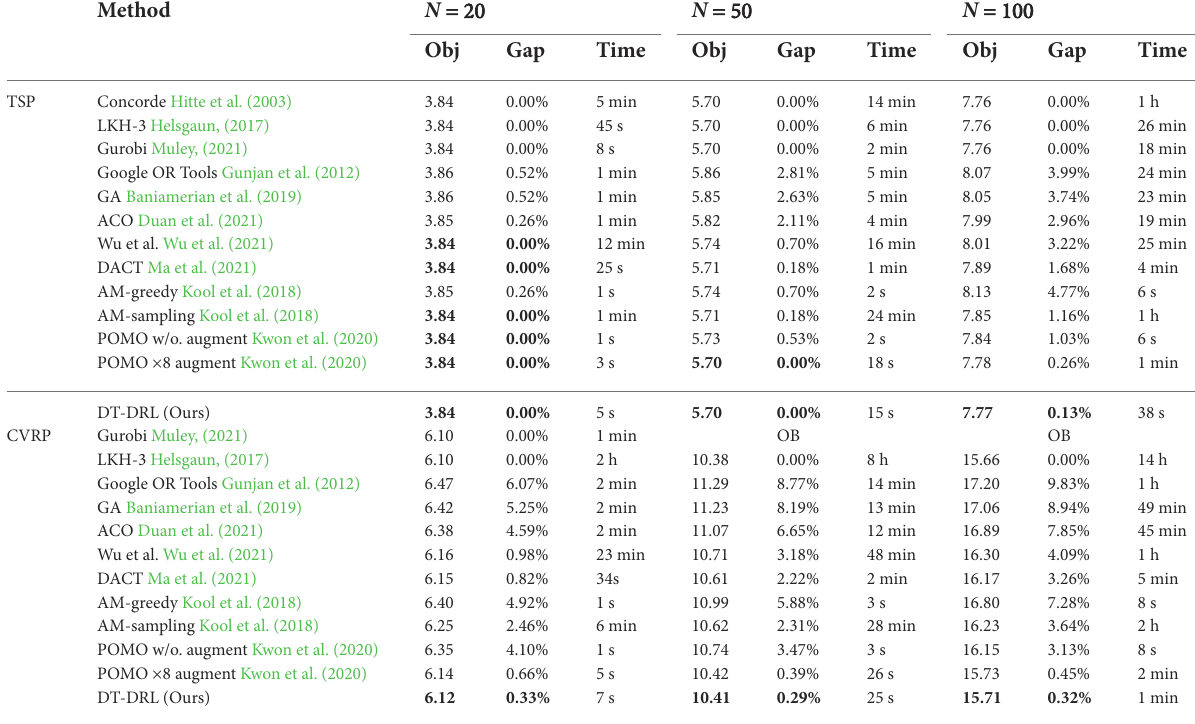
TABLE 1 Comparisonresultswithexact,heuristic,andDRL-basedbaselinesonTSPandCVRP.Boldnumbersindicatethebestresultsamonglearning-based methods.OBmeansoutofbudgetand“w/o.”isshortforwithout. Method